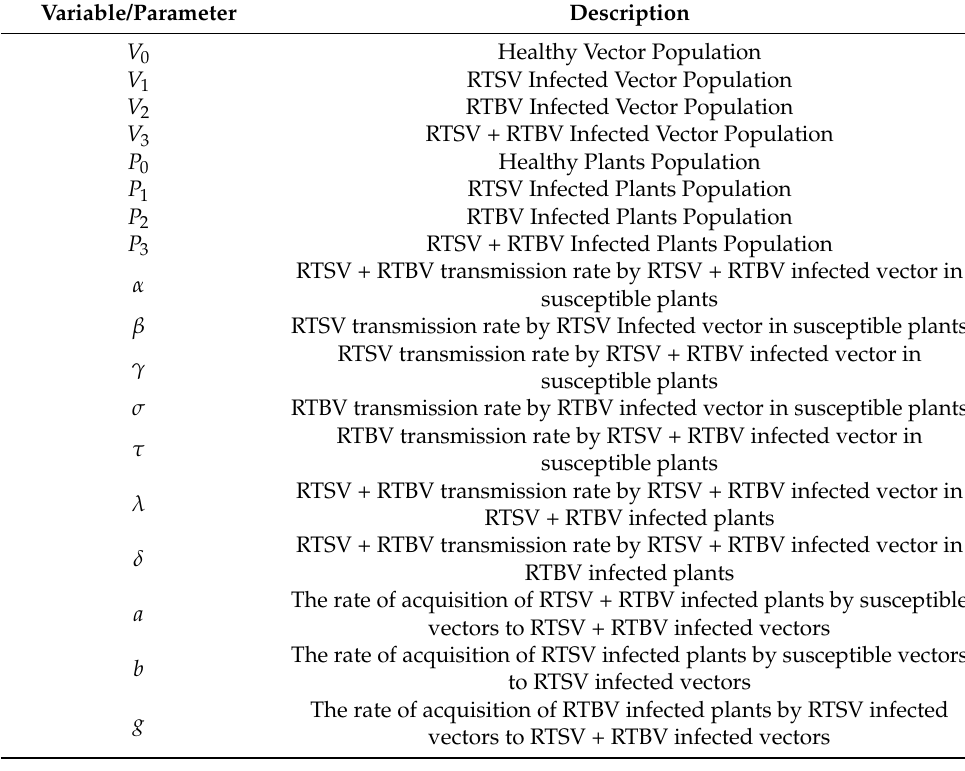
Table 4. Description of variables [21].